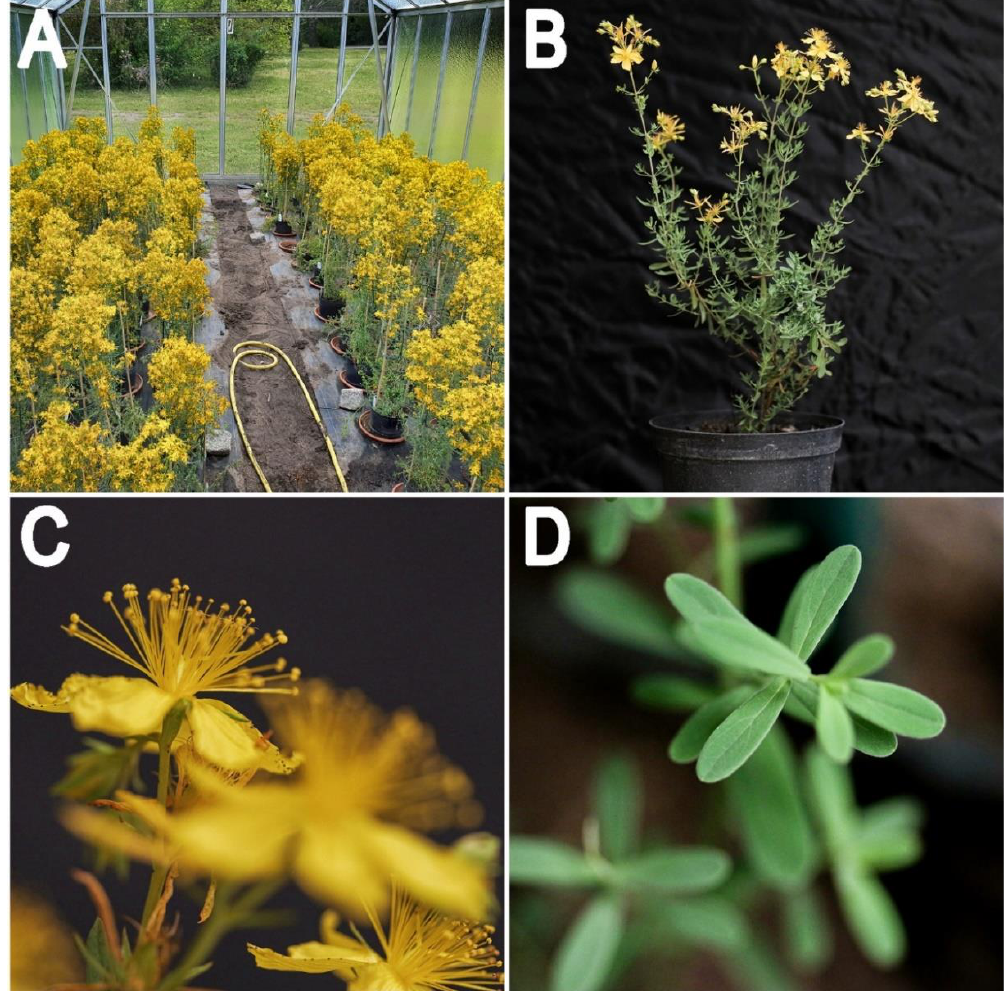
Figure 1. Canopy and appearance of plants of Hypericum perforatum. ( A ): Greenhouse cultivation of a sexual diploid genotype (HyPR-01); ( B ): Single plant 7 months old in full flowering; ( C ): Detail of open flowers; ( D ): Detail of adult leaves. Photos by Paride Rizzo.